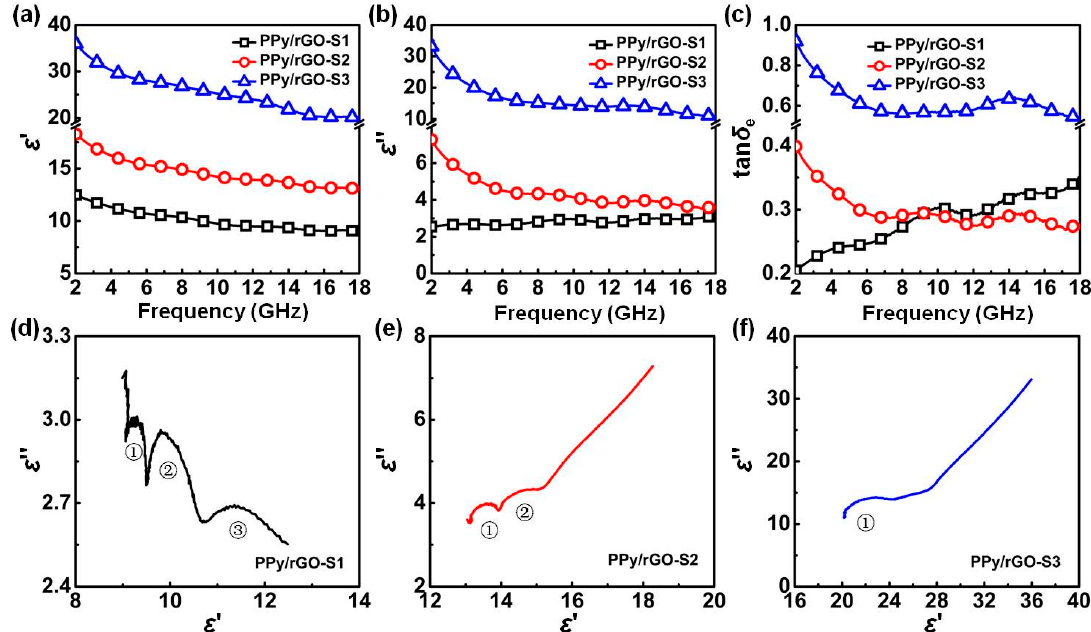
Figure 7. Real parts ( a ) and imaginary parts ( b ) of the complex permittivity of PPy/rGO-S1, PPy/rGO-S2, and PPy/rGO-S3, and their corresponding dielectric dissipation factor ( c ) in the frequency range of 2.0–18.0 GHz; typical Cole–Cole semicircles ( ε ″ vs. ε ′ ) for PPy/rGO-S1 ( d ), PPy/rGO-S2 ( e ), and PPy/rGO-S3 ( f ). Polymers 2018 , 10 , x FOR PEER REVIEW 10 of 15